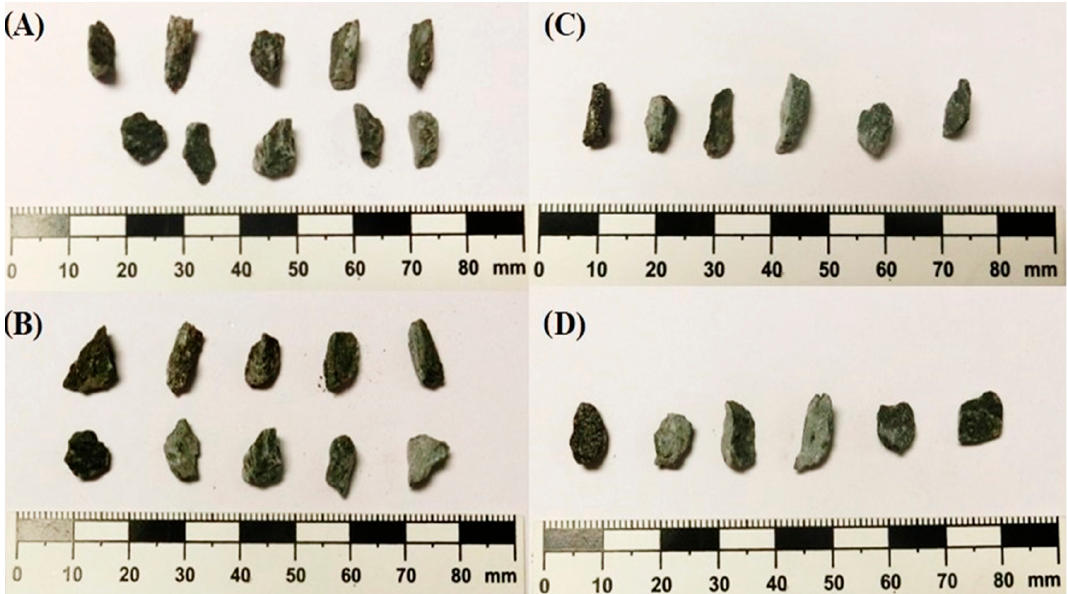
Figure 11. Different views of the calc-silicate particles in the size range of 5 mm to 6.7 mm. ( A ) Feed in profile view; ( B ) feed in front view ( C ) product in profile view and ( D ) product in front view.